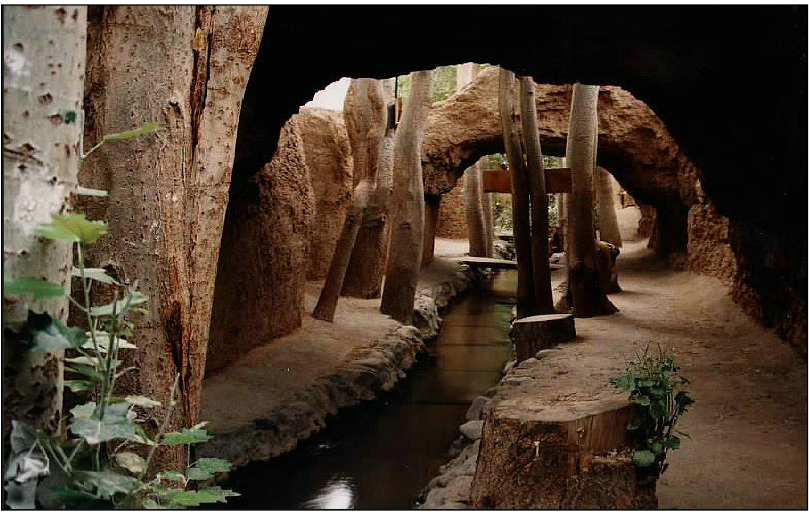
Figure 6. Qanat in